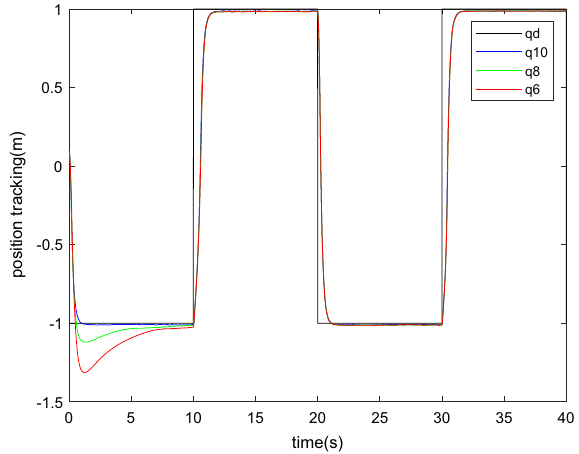
Figure 15. Position tracking result.